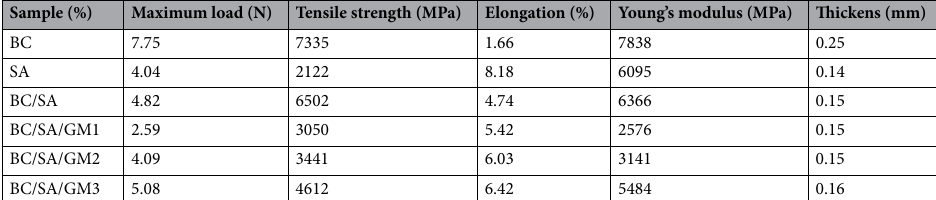
Table 4. Mechanical properties of BC membrane and BC fabricated composites.